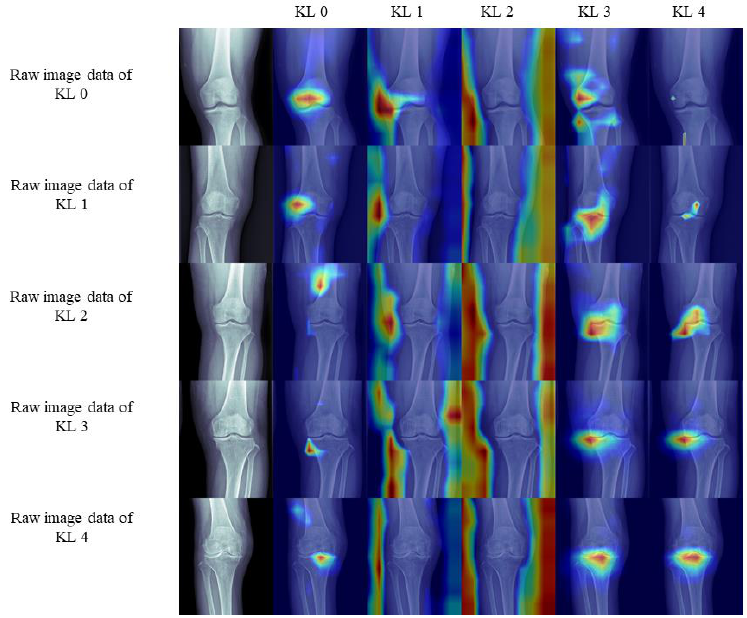
Figure 5. Qualitative results: Gradient-weighted class activation mapping.